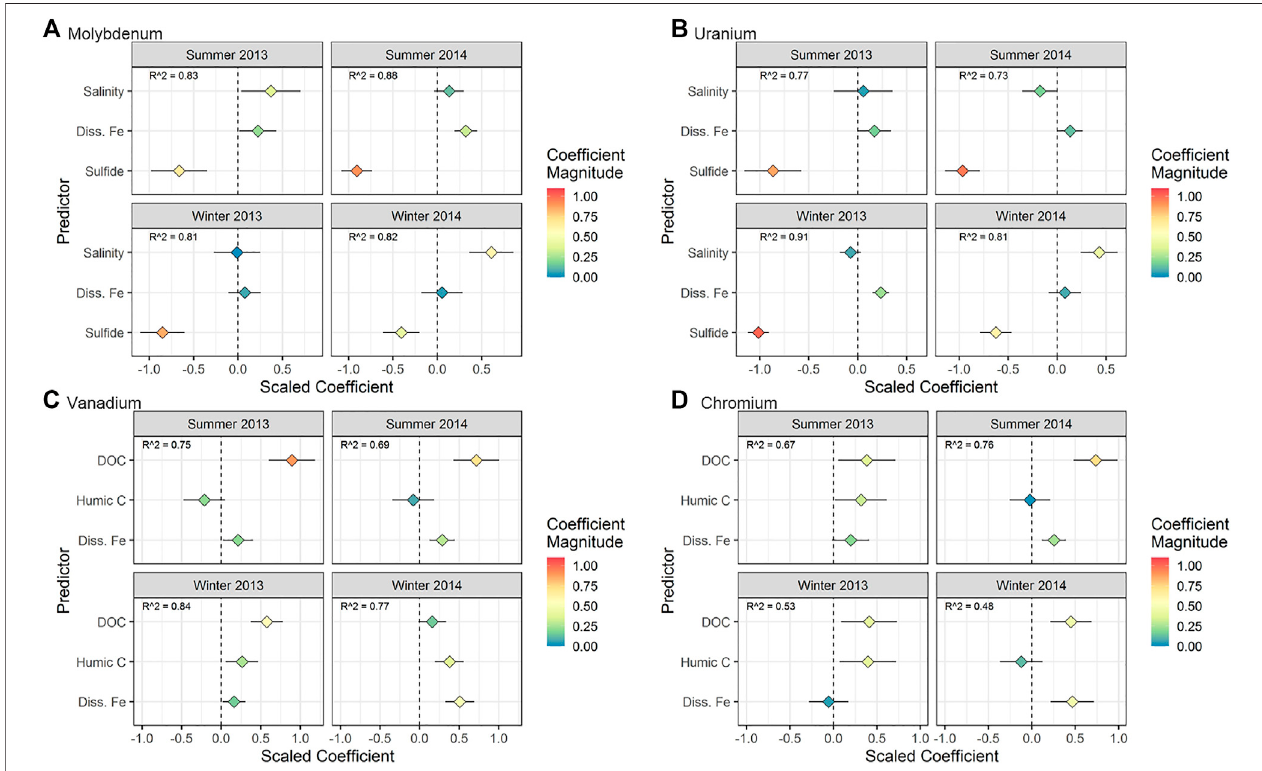
FIGURE6| Regressionresultsfor (A) Mo, (B) U, (C) V,and (D) CrforthetimeseriestakenattheMTsamplinglocation(timeeffects).Thehorizontalaxisrepresents the scaled coef fi cient for each predictor in the multiple linear regression (vertical axis). The color of the points shows the absolute magnitude of the coef fi cient. More extreme values (positive or negative) represent a stronger relationship between the predictor and the metal concentration. The horizontal lineassociated with each point represents the 95% con fi dence interval for the coef fi cient. For points where the con fi dence interval does not intersect 0, the p value for the coef fi cient is <